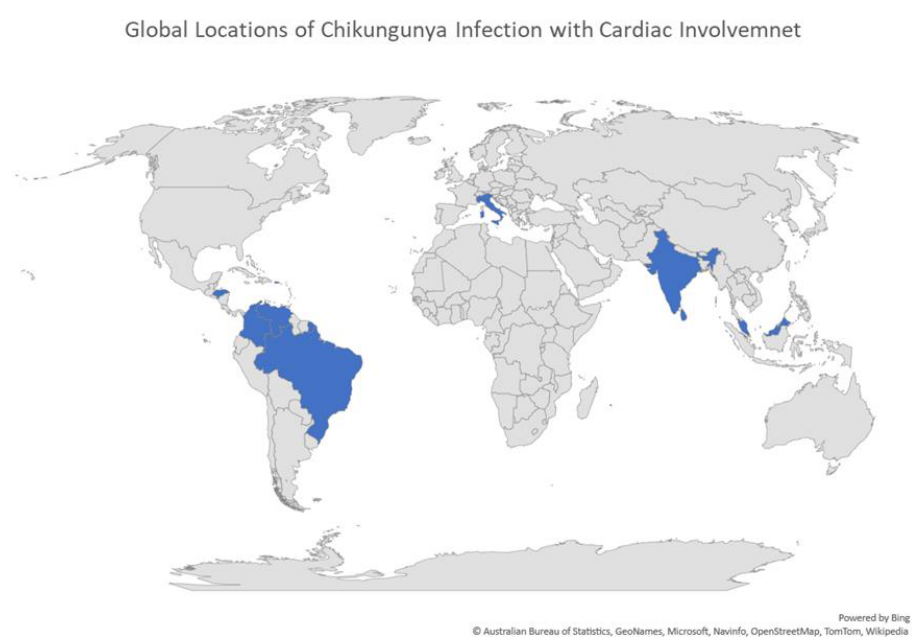
Figure 1. Countries in which a CHIKV infection involved altered cardiac status spanning 1970 – 2020.